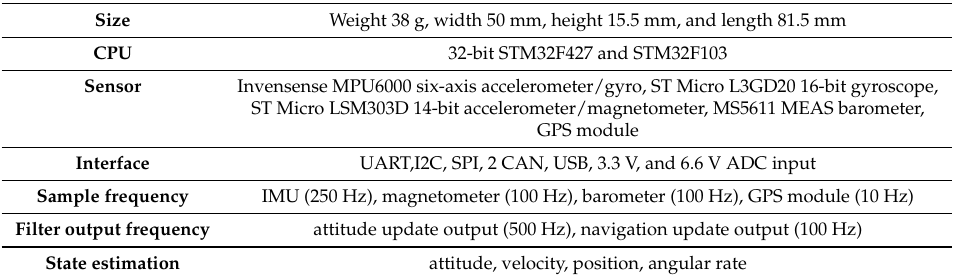
Table 2. The UAV commercial autopilot specifications.